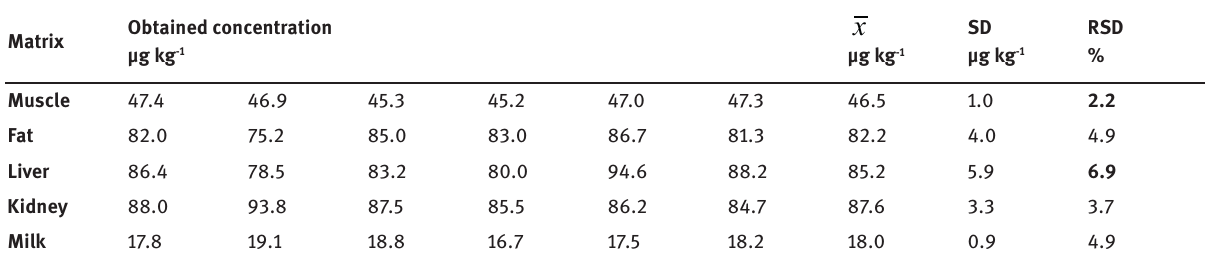
Table 3: Repeatability on different fortified bovine samples.